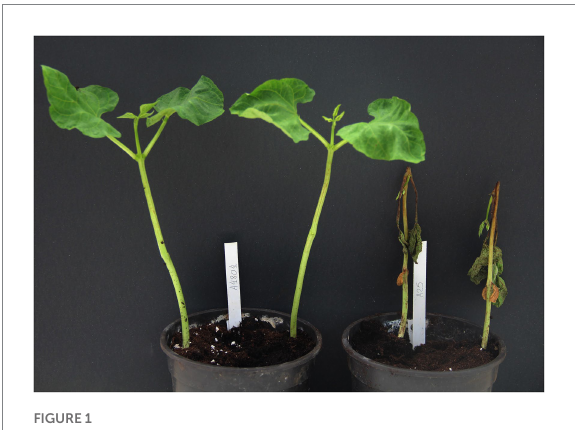
FIGURE 1 Reactions of the genotype A4804 (left; resistant) and A25 (right; susceptible) against monosporic isolates Cl18 (race 38) 7 days after